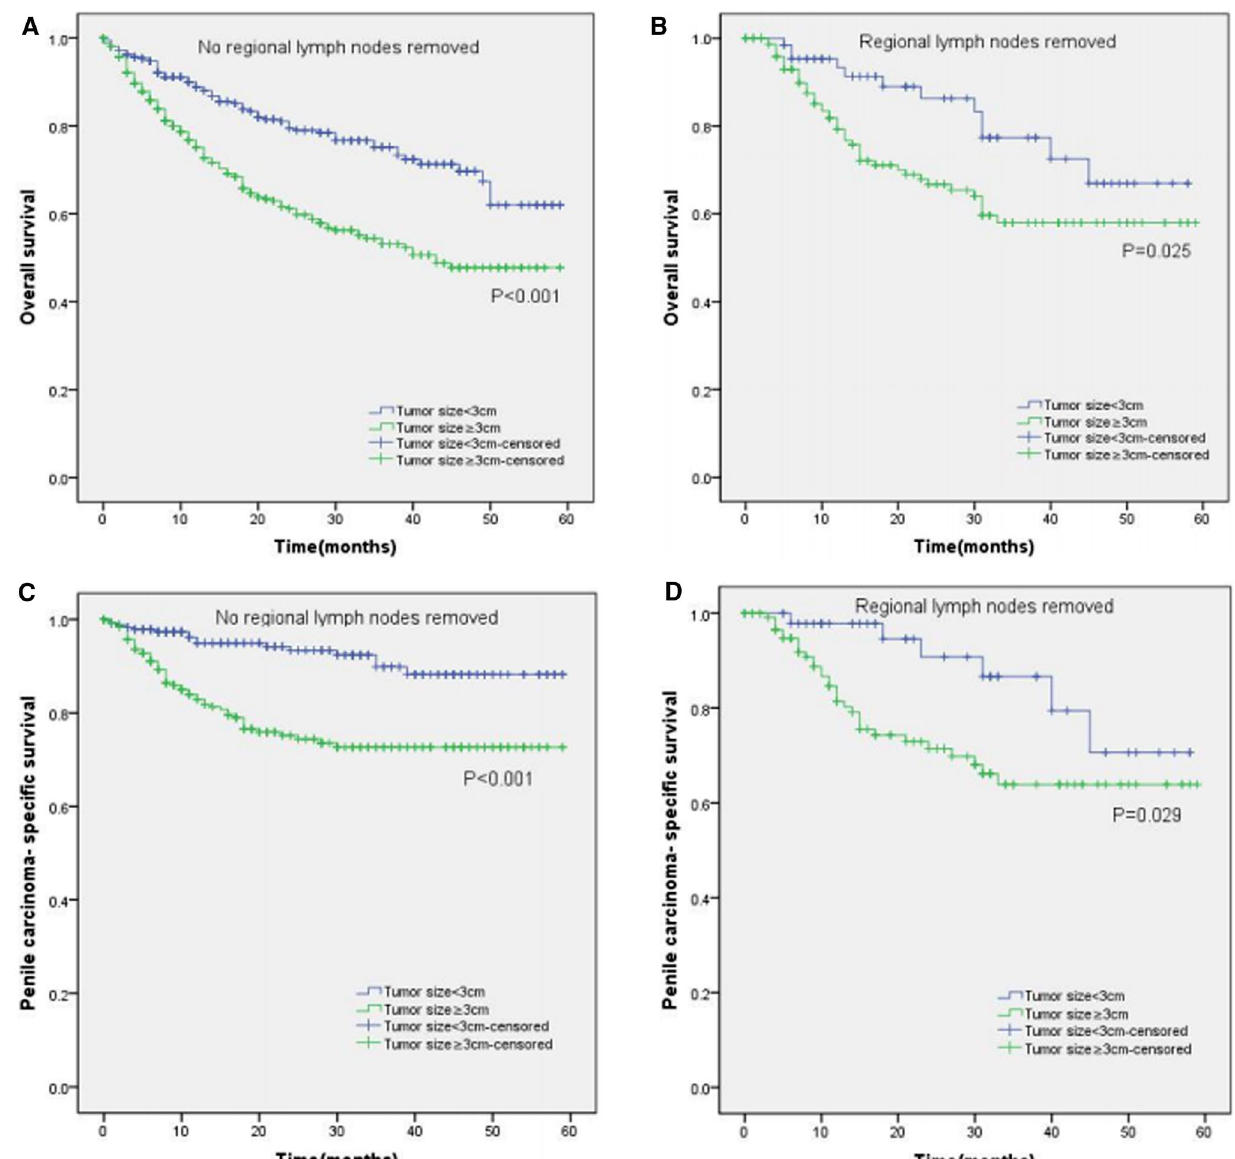
Fig. 9 Kaplan–Meier analyses of overall survival ( A , B ) and penile carcinoma-specific survival ( C , D ) between no regional lymph nodes removed group and regional lymph nodes removed group in patients stratified by tumor